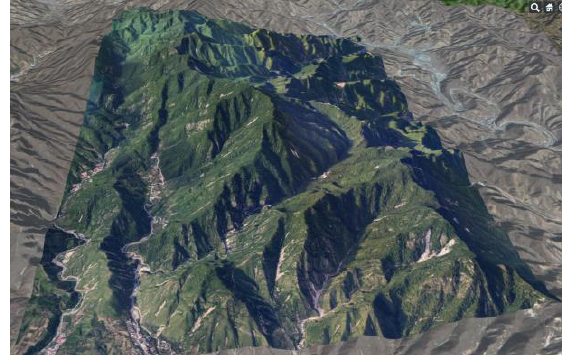
Figure 5. 3D visualization of the research area